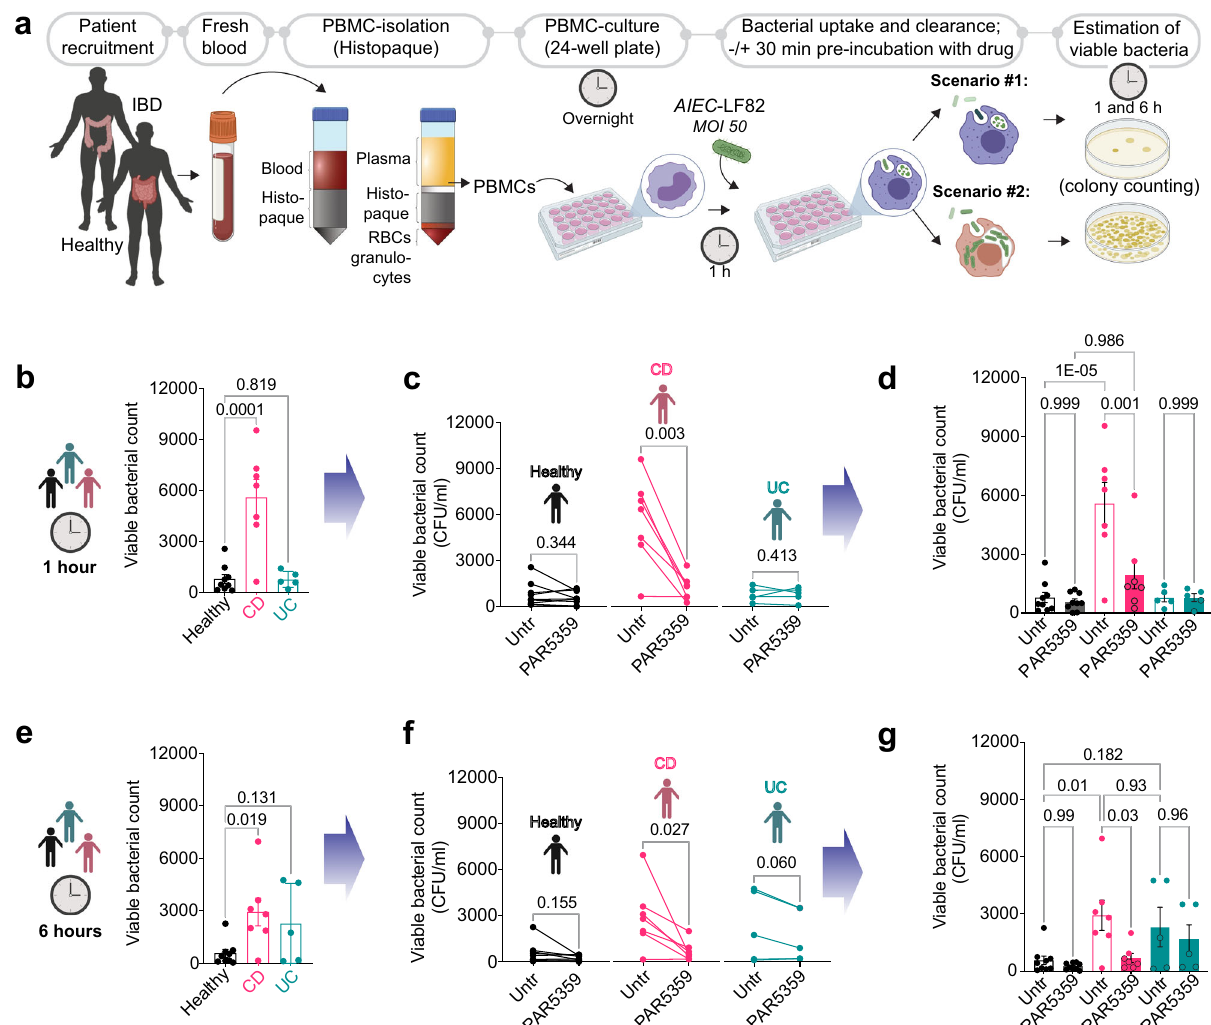
Fig. 7 PPAR α / γ dual agonist, PAR5359, promotes the clearance of AIEC -LF82 from CD patient-derived PBMCs. a Schematic displays the overall experimental design using human subjects (see Supplementary Table 5 for patient demographics). Peripheral blood collected from healthy, CD, and UC patients was used as a source of PBMCs. PBMCs were pre-treated for 30 min with 1 μ M PPAR α / γ agonists prior to infection with AIEC -LF82 ( MOI 50) for 1 h. PBMCs were subsequently treated with gentamicin to kill extracellular microbes for 60 min (~t0 h) prior to lysis and plating to determine the intracellular abundance of viable bacteria at 1 and 6 h, as determined by dilution plating and colony counts (see Methods for details). b – g Bar graphs with scatter plots display the abundance of viable intracellular bacteria at 1 h ( b ) and 6 h ( e ) after infection. Paired line plots display the rate of clearance of bacteria in individual subjects at 1 h ( c ) and 6 h ( f ) after infection. Data in ( b , c ) of 1 h infection is combined in ( d ) and data in ( e , f ) of 6 h infection is combined in ( g ) with statistics: Results are displayed as mean ± SEM (CD patient n = 7, UC patients = 6, and healthy n = 9). Paired t -test or one-way ANOVA followed by Tukey ’ s test for multiple comparisons was performed to test signi fi cance. Signi fi cance: n.s., not signi fi cant, p -value < 0.05 was considered signi fi